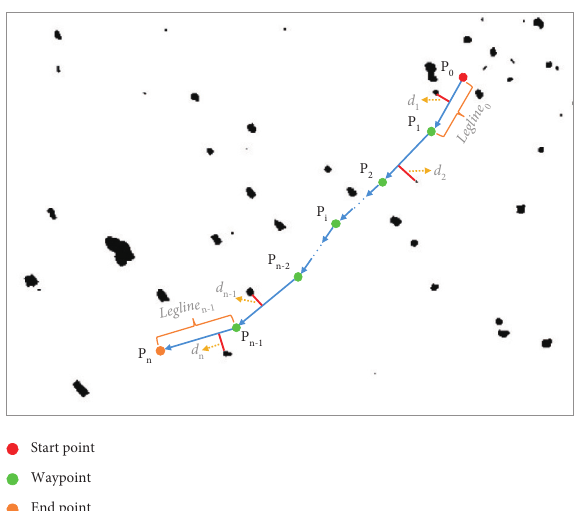
Figure 4: Ship path exploitation with complicated ice navigation